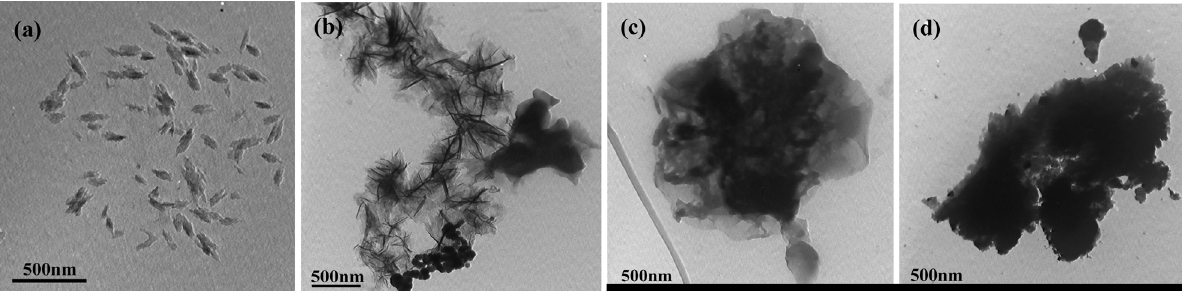
; and ( d ) poly(TMPT)/TiO 2